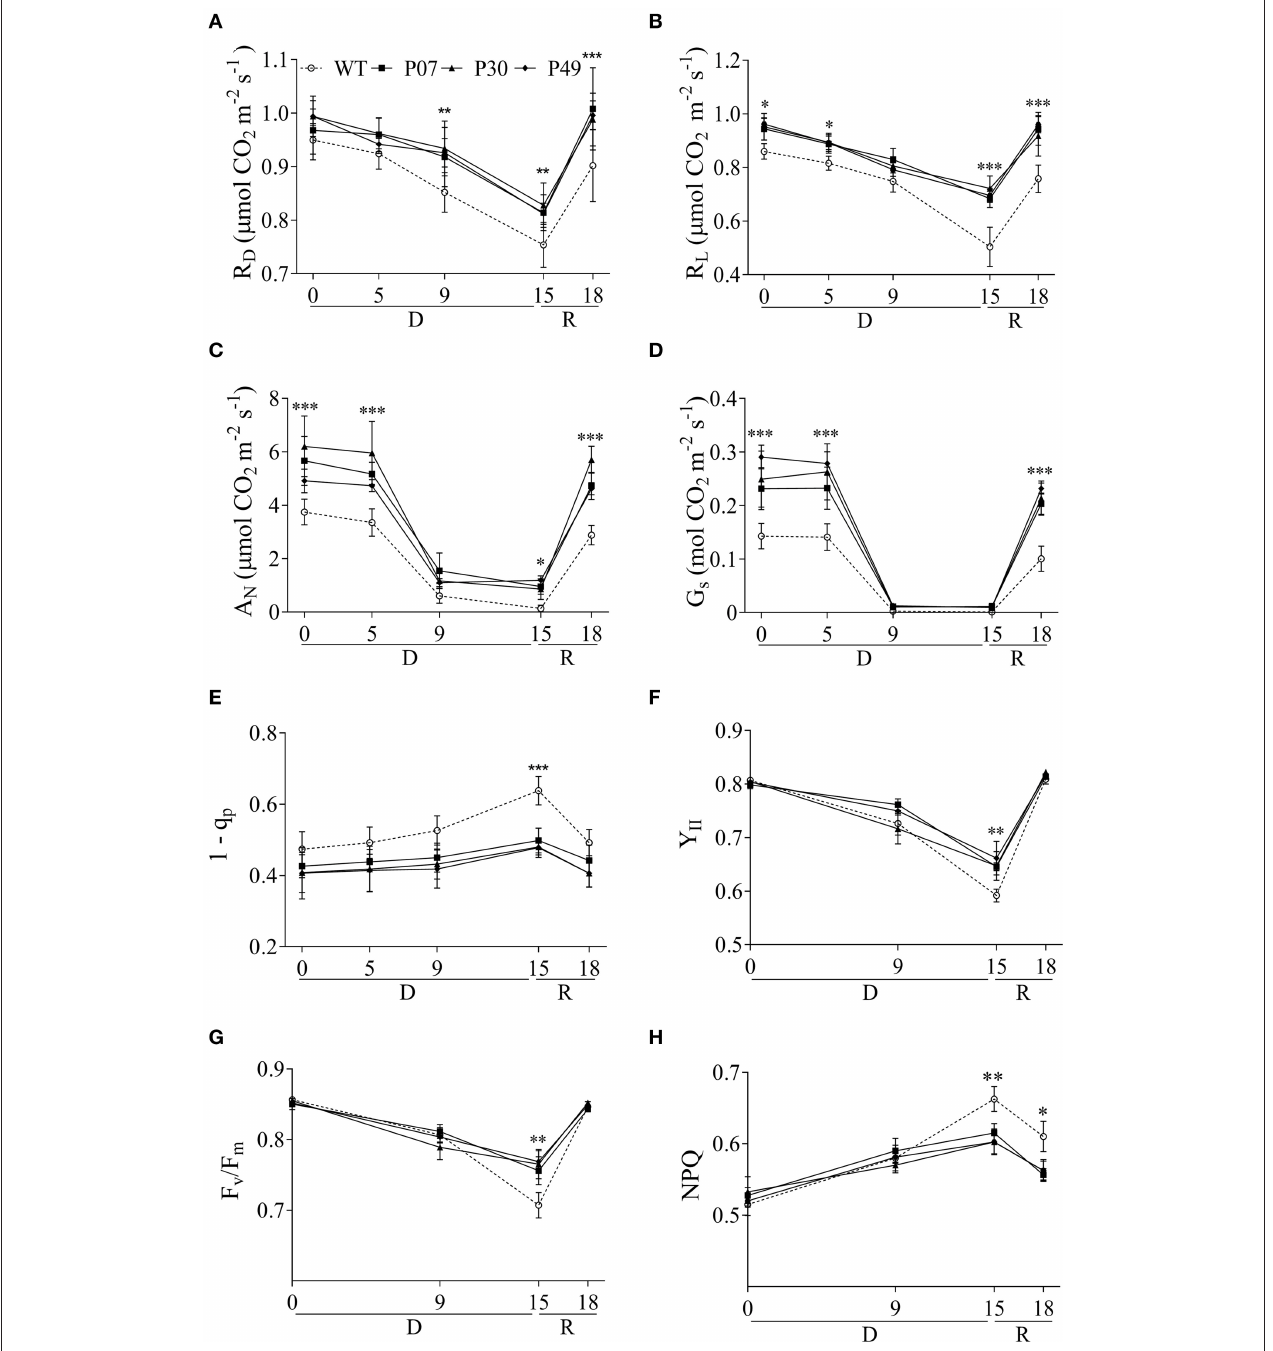
FIGURE 2 | Effects of drought stress on physiological and chlorophyll fluorescence parameters of WT and AtUCP1 -overexpressing transgenic plants. The measurements were taken at growth light intensity (400 µ mol m − 2 s − 1 ) using the first expanded leaf during the whole course of the experiment. For this experiment, plants were allowed to recover from drought stress for 3 days. (A) Respiration in the dark: (R D ), (B) respiration in the light (R L ), (C) net photosynthetic rate (A N ), (D) stomatal conductance (G S ), (E) excitation pressure (1- q P), (F) effective PS II quantum yield during illumination (Y II ), (G) maximal quantum yield of PS II (F v /F m ), and (H) non-photochemical energy quenching (NPQ). Points represent the means of 5 plants ± SD. Points with *, **, and *** mean that all three transgenic lines differ significantly from the WT ( P < 0.1, P < 0.05, and P < 0.01, respectively). D, Drought; R,